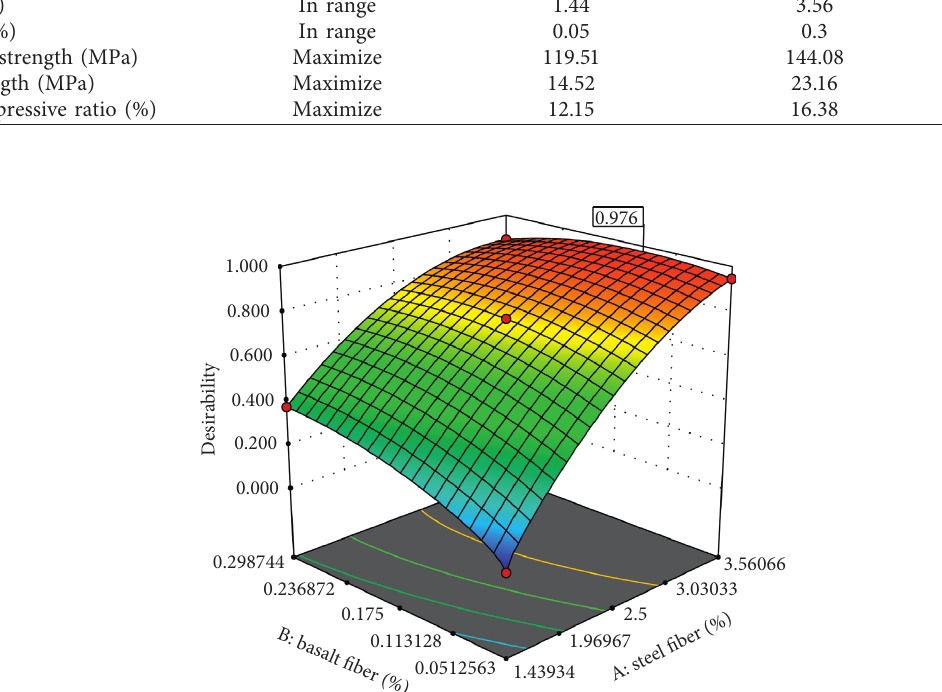
Figure 15: Variation in desirability function based on the multiobjective optimization